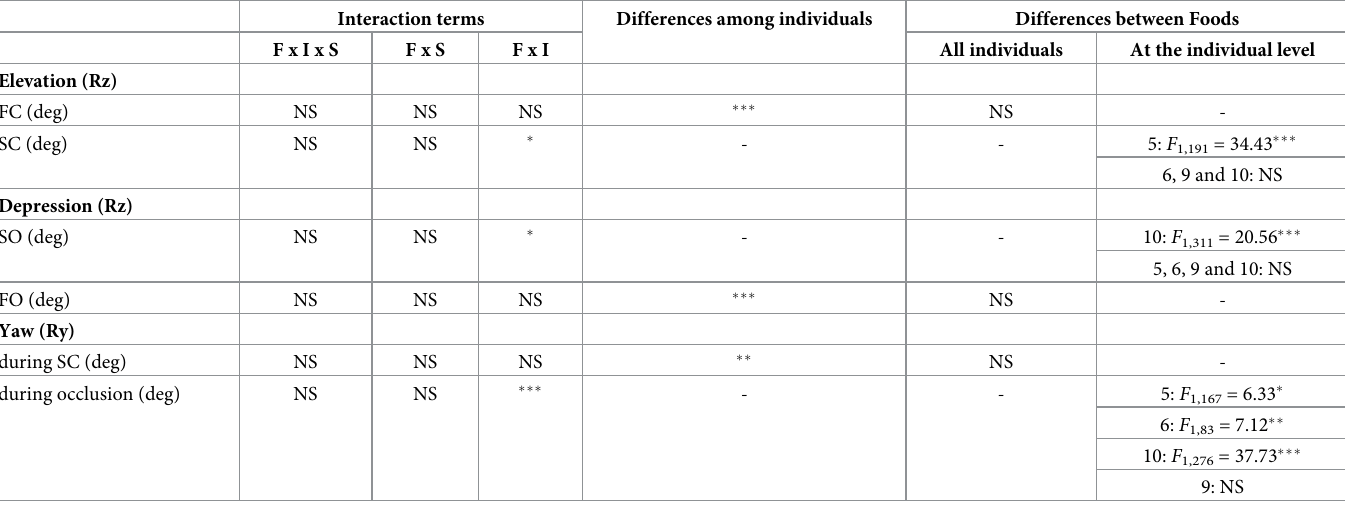
Table 6. Summary of the effects of food stiffness (i.e., carrot versus almond) on the variability of jaw movements. Interaction